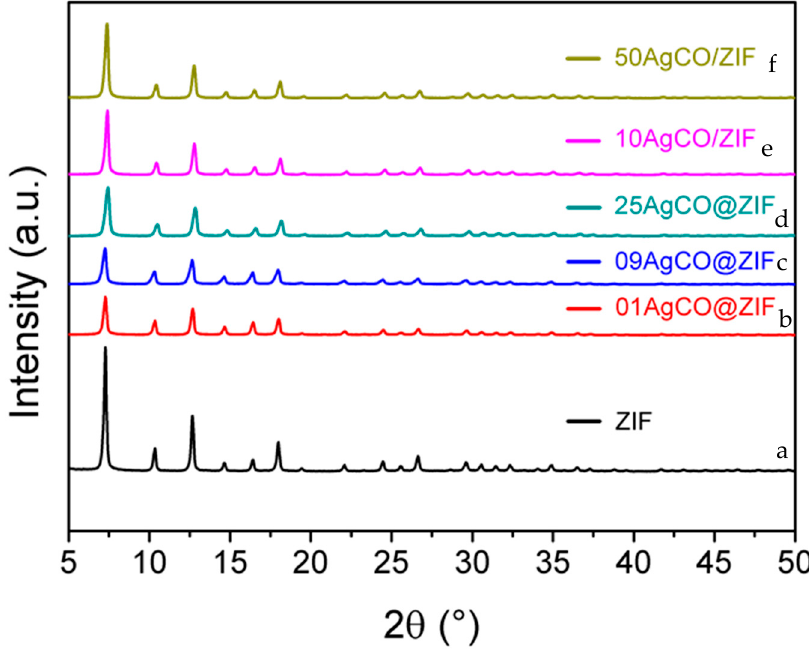
Figure 6. XRD diffraction patterns of ZIF-8 samples with de novo- synthesis (sample as ZIF-8, 01AgCO@ZIF, 09AgCO@ZIF, 25AgCO@ZIF) and prepared with impregnation method (sample as 10AgCO/ZIF, 50AgCO/ZIF) using Ag 2 CO 3 as the precursor. (a) ZIF-8, (b) 01AgCO@ZIF (de novo), (c) 09AgCO@ZIF (de novo), (d) 25AgCO@ZIF (de novo), (e) 10AgCO/ZIF (impregnation), (f) 50AgCO/ZIF (impregnation).